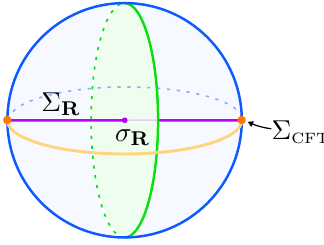
Figure 15 . A cross-section of the Euclidean geometry f M 1 . The orange semicircle and its comple- ment along a time slice represent the orange shaded region of (cid:12)gure 14 and its complement. The rotation that keeps (cid:6) (cid:12)xed represents euclidean time. An in(cid:12)nitesimal conical defect (cid:6) R runs CFT through the bulk and intersects the brane at (cid:27) R